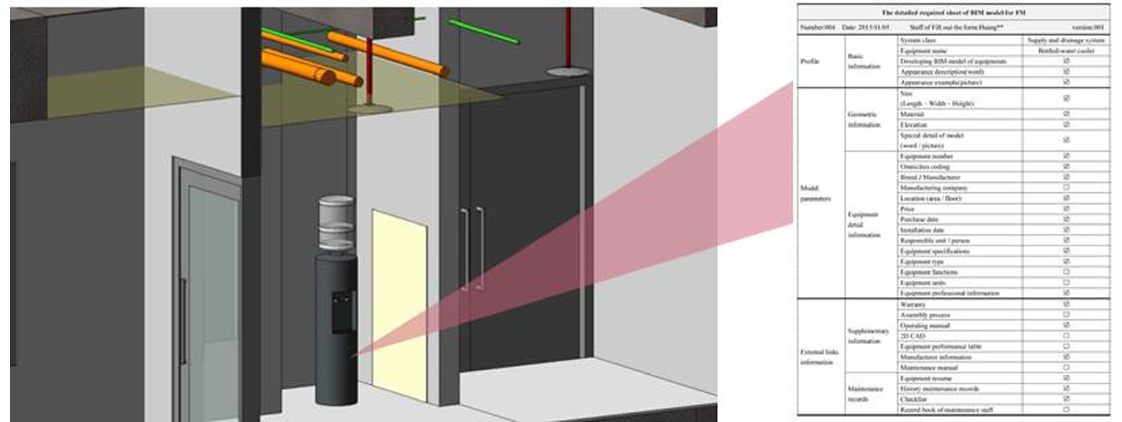
Figure 5. Updated As ‐ Built BIM model of bottled water cooler used in the case study.